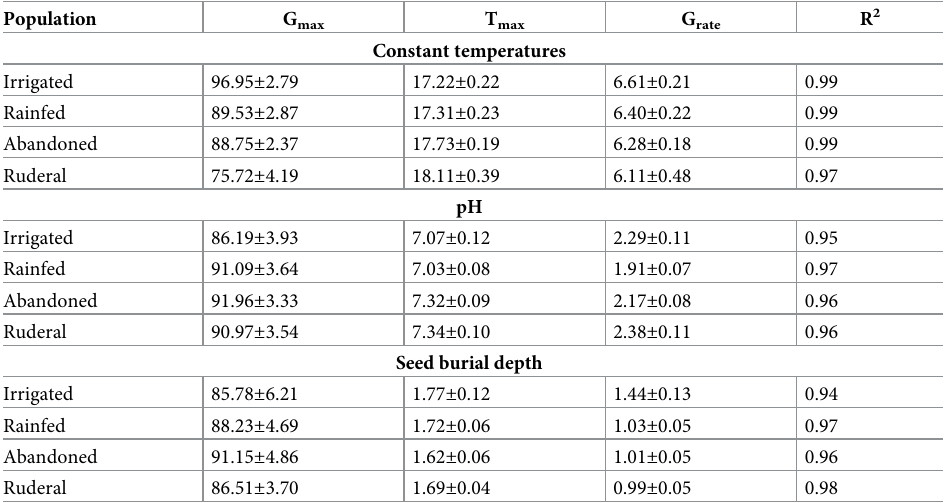
Table 4. Effect of different environmental conditions on seed germination of different populations of Conyza stricta Willd. modeled with three parametric Gaussian equation. Population G max T max G rate R 2